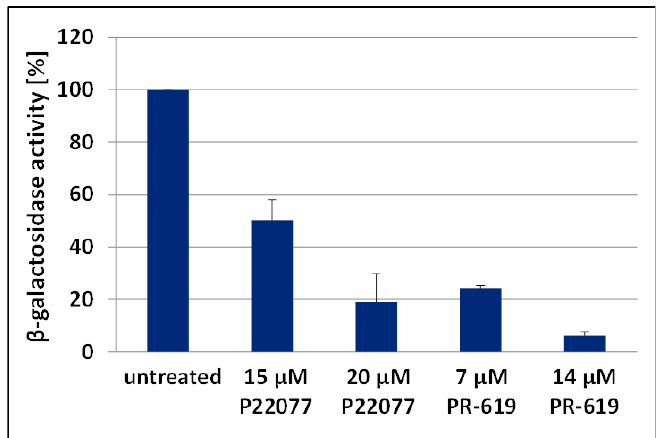
Figure 3. DI treatment reduces the infectivity of released virions. HEK293T cells were transfected with plasmids coding for vesicular stomatitis virus-glycoprotein (VSV-G) and pNL env 1. The pseudotyped pNL env 1 VLPs were collected following treatment with 15 or 20 μM P22077 and 7 or 14 μM PR-619 for 24 h. TZM-bl cells were infected with 1 ng of p24 equivalent derived from purified VSV-G pseudotyped pNL env 1 VLPs. Infectious titers were determined by measuring the β -galactosidase activity. Bars represent the mean values of 3 independent experiments ± SD.